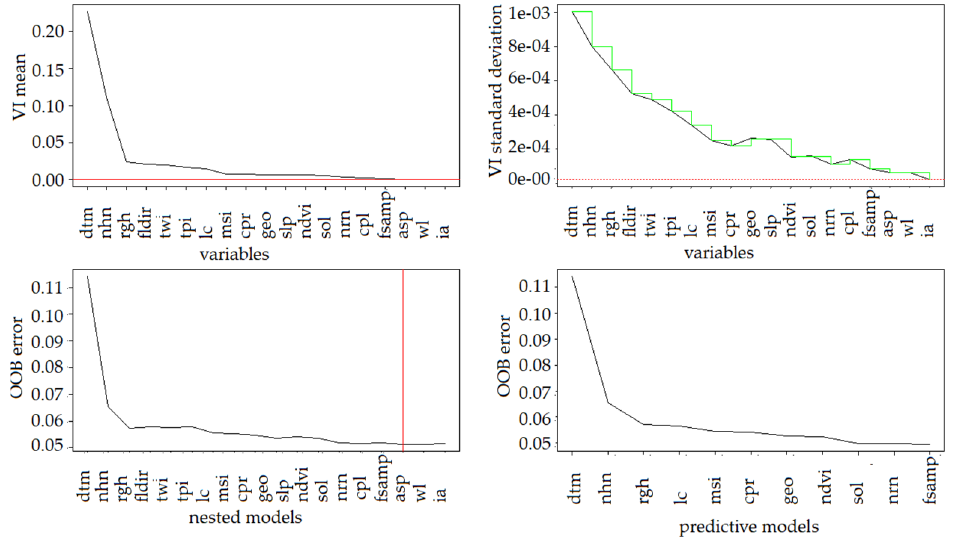
Figure 3. HG variables of importance, NB. Upper left , mean variable importance, upper right : standard deviation of the variable importance, bottom left : mean OOB error rate of interpretation step of RF models, bottom right : mean OOB error rate of prediction step of RF models. Red lines indicate thresholds. The green line represents predictions given by a CART tree fitted to standard deviations.